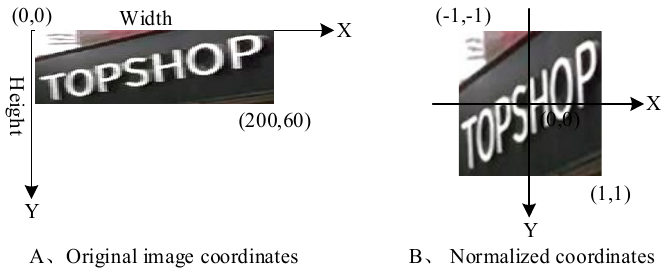
Figure 3. Schematic diagram of coordinate normalization.